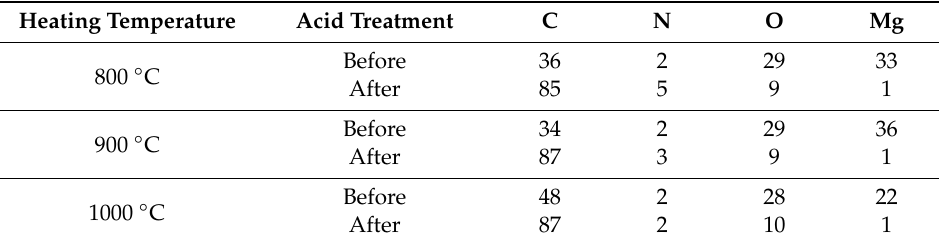
Figure 2. XPS spectra of the carbonized products prepared by heating at ( a ) 800 ◦ C, ( b ) 900 ◦ C, and ( c ) 1000 ◦ C: Before sulfuric acid treatment (black) and after sulfuric acid treatment (red, blue, and purple). Table 1. Amounts of C, N, O, and Mg in the carbonized products (in